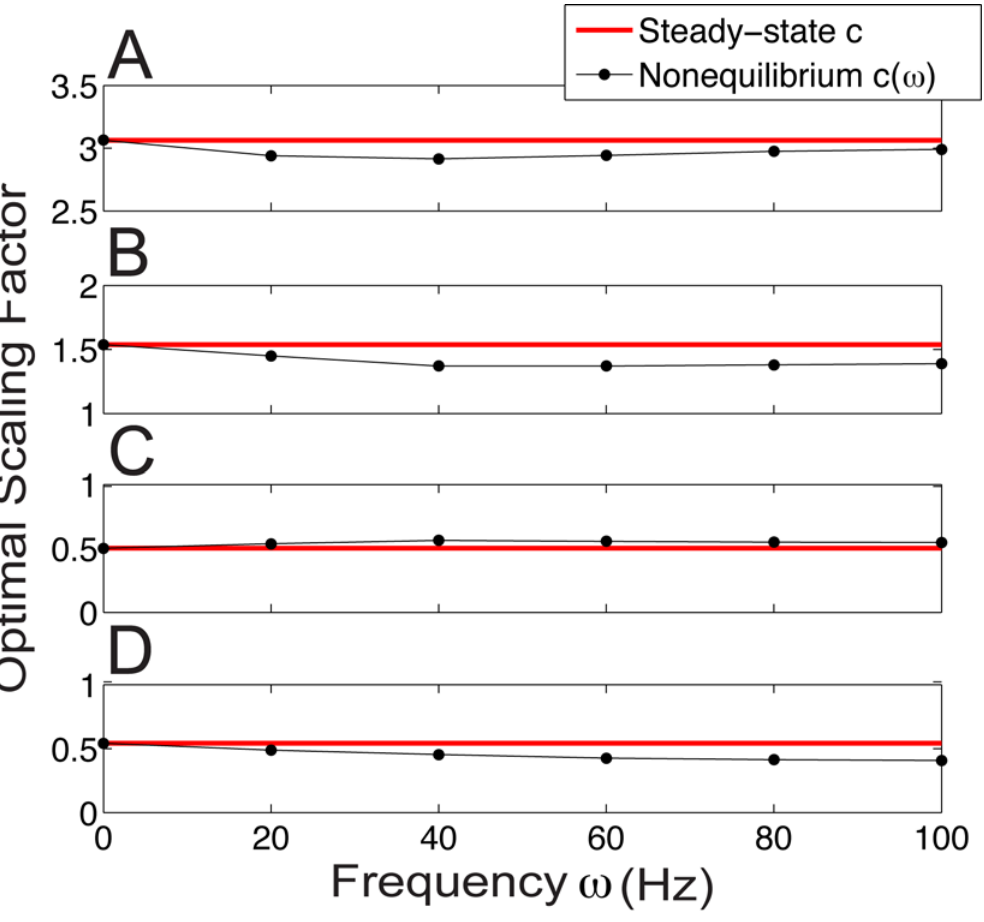
Figure 7. Optimal scaling factor for sinusoidal input compared with equlibrium scaling factor. The red line is the optimal scaling factor c eq (11) of the equilibrium input/output curves computed for 0 v n d v n max , and the black line with dots is the optimal scaling factor c v ð Þ (14) of the two dynamical responses with sinusoidal input n d t ð Þ . The scaling factors match very well for a variety of pairs of balanced background synaptic inputs. Top panels to bottom panels have background synaptic input rates of: (A) n 0